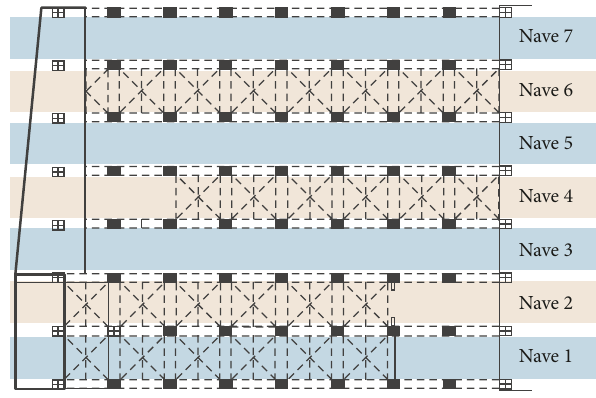
Figure 2: Floor plan, naves 1–7, Reales Atarazanas de Sevilla (Seville Royal Dockyards).